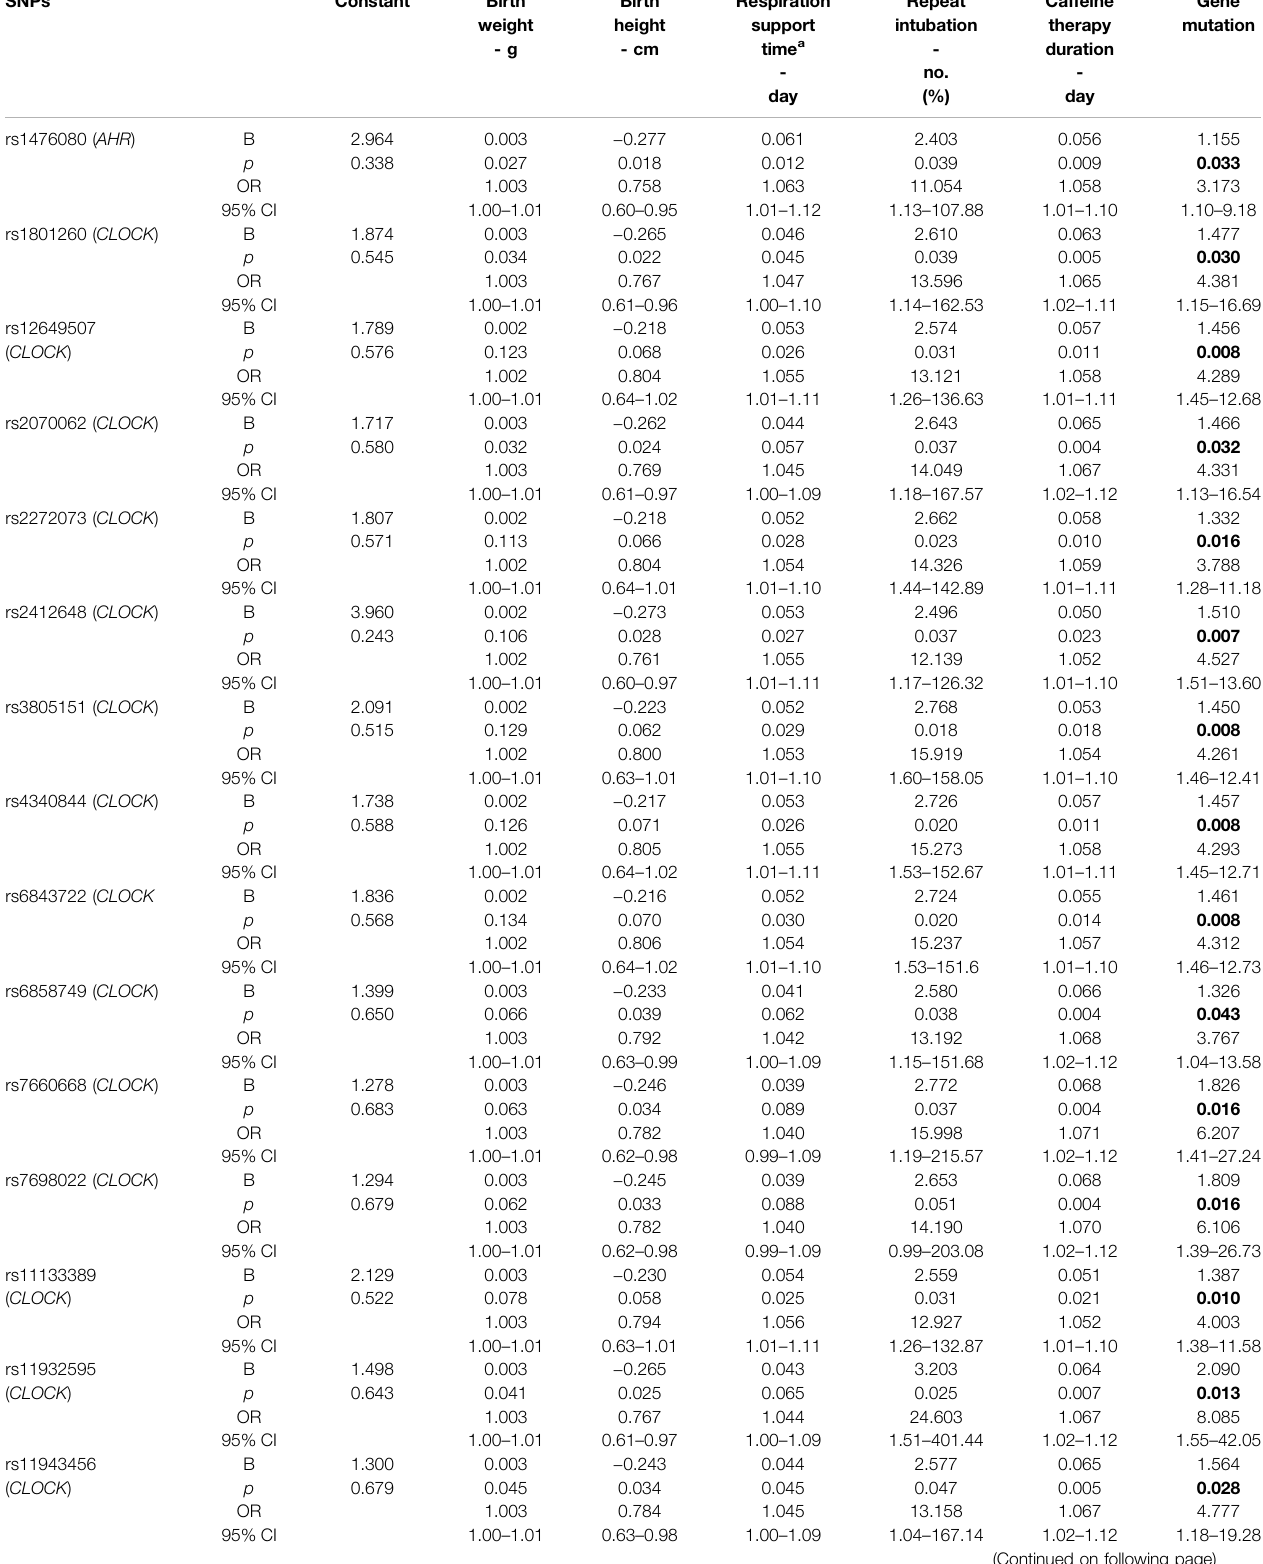
TABLE 3 | Results of multivariable logistic regression analysis to examine the effects of AHR and CLOCK gene polymorphisms on caffeine therapy in apnea-free group and apneic preterm infants.